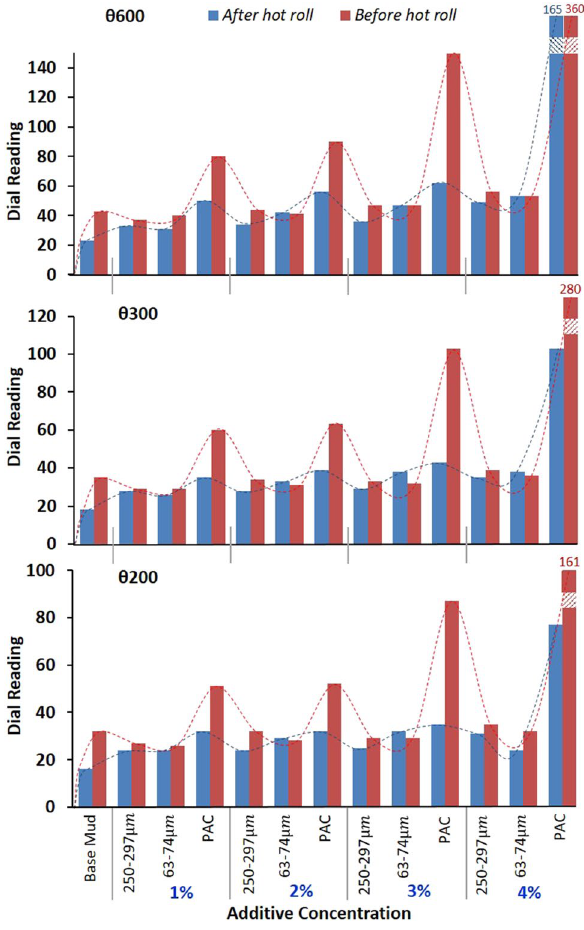
Fig. 12 A comparative analysis illustrating the variation in shear stress in terms of the dial reading in a decreasing pattern from θ600 to θ200 before and after hot roll. It is seen that the before hot roll readings of shear stresses remain in close range to each other for the proposed additive, but the PAC readings are showing increasing stresses after the hot roll at all